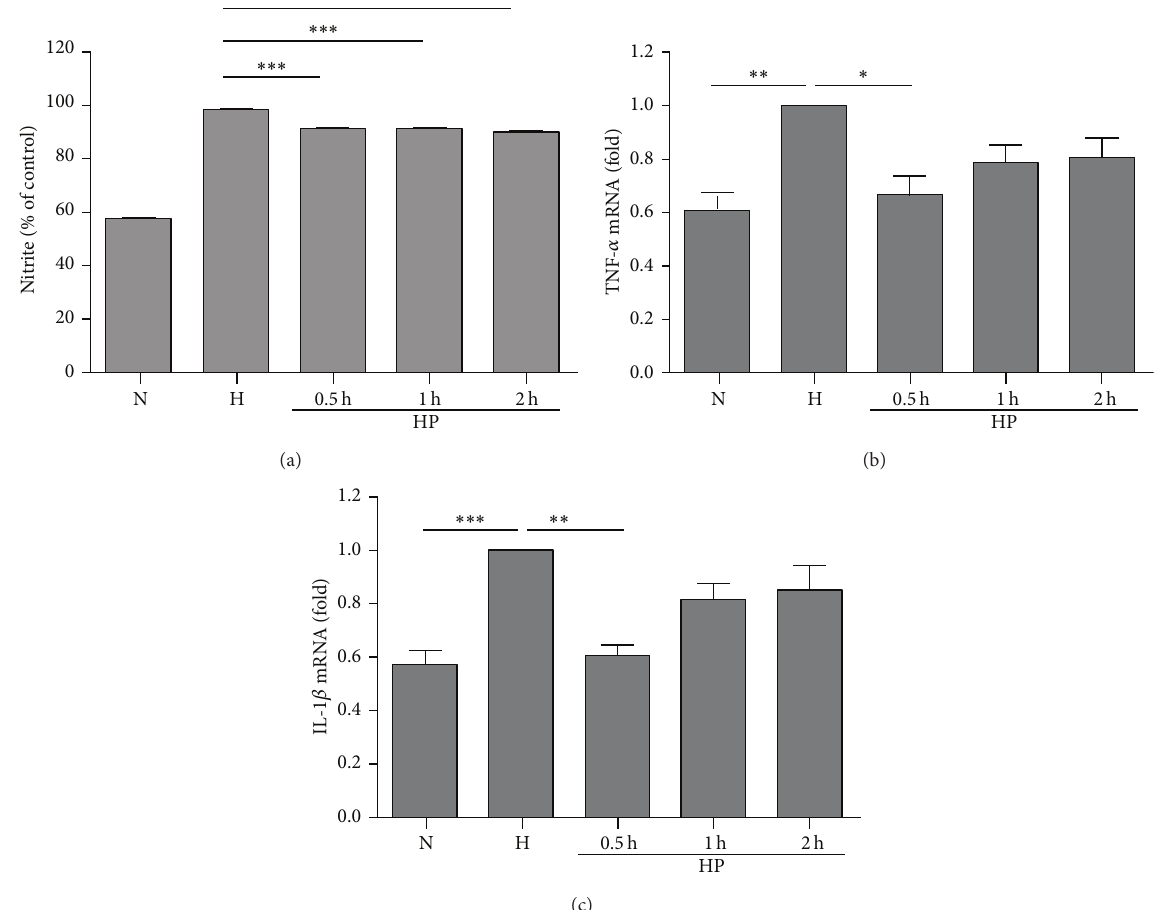
Figure 6: Hypoxia preconditioning suppresses prolonged hypoxia-induced inflammation in the BV-2 microglial cell line. (a) Brief hypoxia exposure (0.5, 1, and 2h) before prolonged hypoxia damage (4h) significantly reduced the production of nitrite. ∗∗∗ 𝑃 < 0.001 compared with hypoxia control. (b) mRNA expression of tumor necrosis factor-alpha (TNF- 𝛼 ) was suppressed by brief hypoxia preconditioning. ∗∗ 𝑃 < 0.01 compared with normoxia control and ∗ 𝑃 < 0.05 compared with hypoxia control. (c) mRNA expression of interleukin-1 beta (IL-1 𝛽 ) was also suppressed by brief hypoxia preconditioning. ∗∗∗ 𝑃 < 0.001 compared with normoxia control and ∗∗ 𝑃 < 0.01 compared with hypoxia control. ((a), (b), (c)) The data represent the mean ± standard error of the mean (SEM), based on five independent experiments in each group.